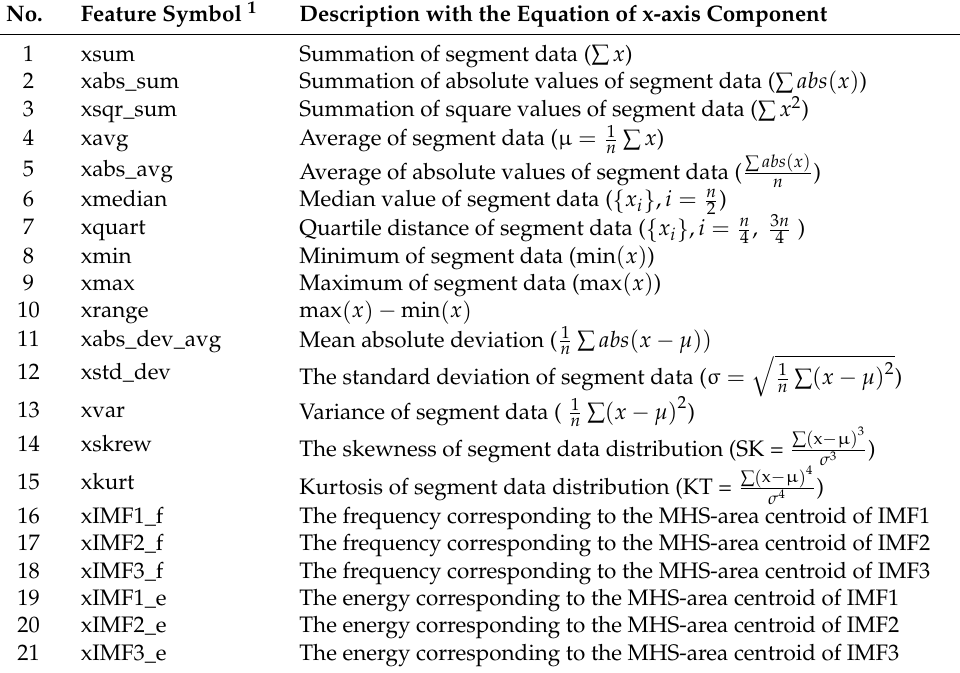
Table 3. The feature patterns including the possible variables in time and frequency domains.